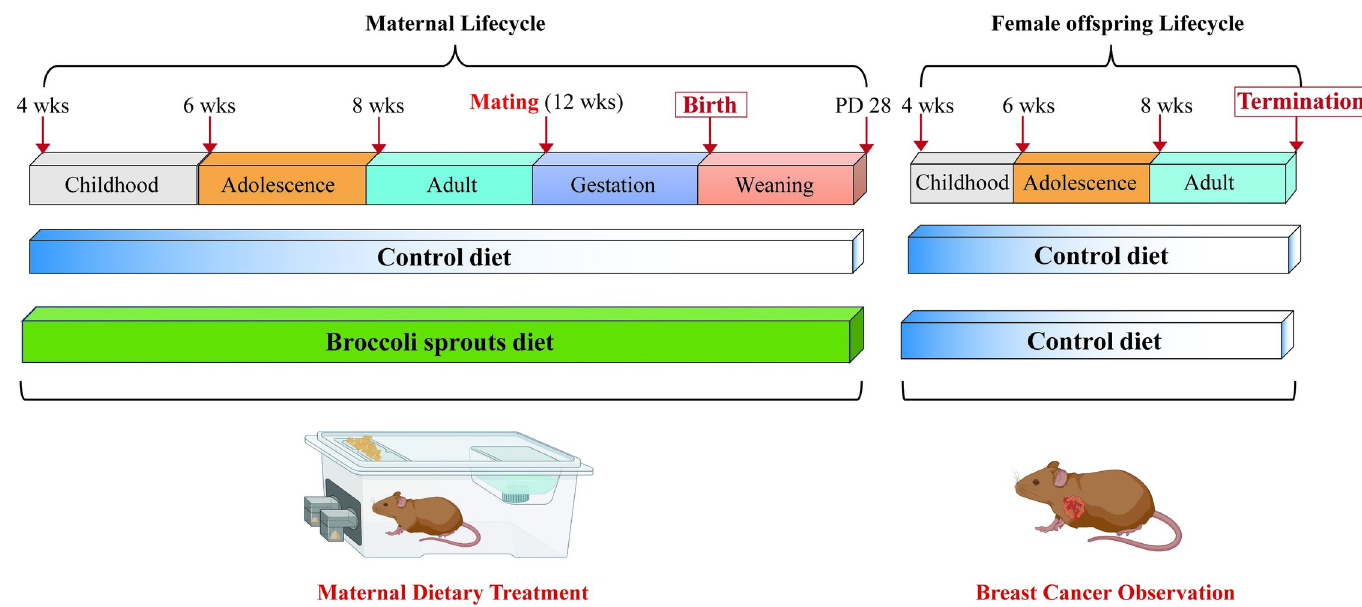
Fig 1. Schematic representation of study design. The upper bar represents different life stages in the mother and female offspring. Transgenic mice were administered either Control or BSp diet resulting in 2 treatment groups (10 mice/group): 1) Control: mothers were fed ad libitum (AL) with the Control AIN-93G diet; 2) Maternal BSp treatment (BSp): The BSp diet was given to the mothers from early life at 4 wks of age until weaning at postnatal days (PD28), representing a persistent eating habit throughout the lifespan. Mothers were mated around 12 wks of age following the period of 3 wks of gestation, resulting in ~20 offspring mice in each group. Offspring mice were weaned at 4 wks of age and maintained on Control diet throughout their